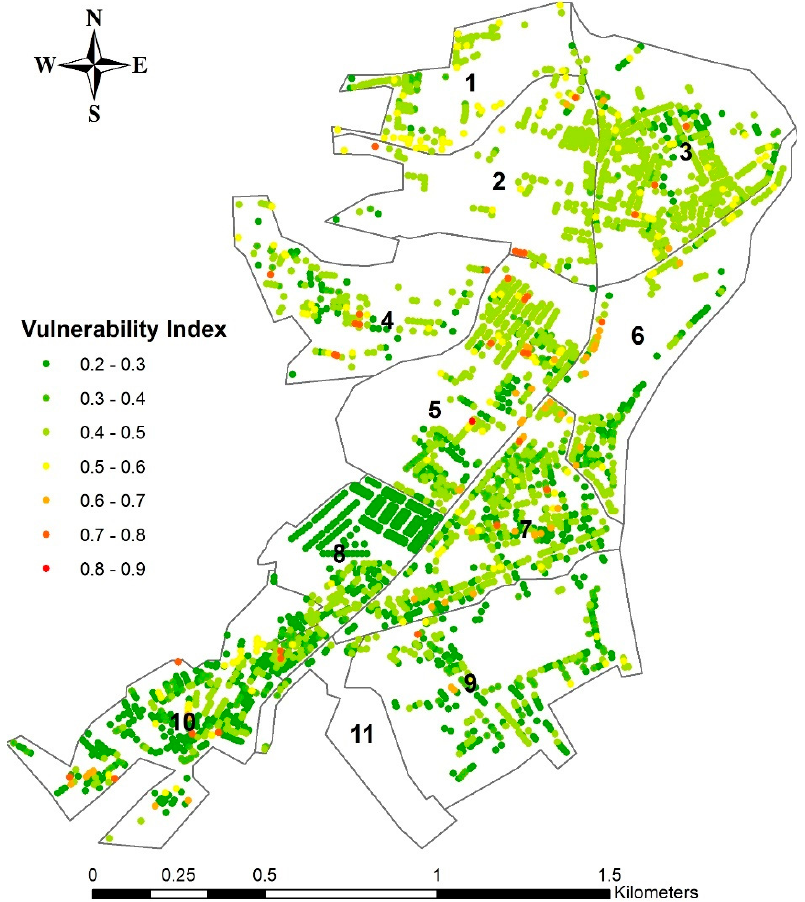
Table 4. Mean Vulnerability Indices (MVI) for the Districts of Imzouren.